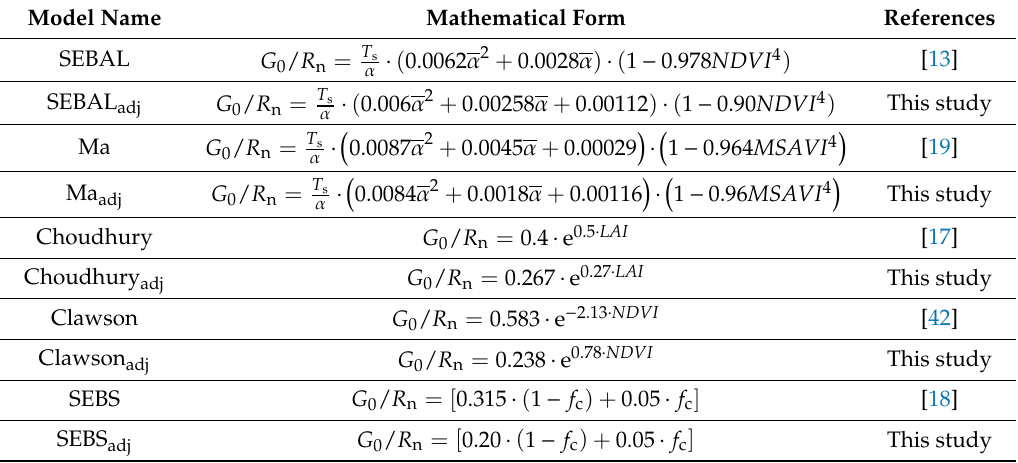
Table 3. The original and adjusted versions of remote sensing-based models estimating G 0 / R n . Model